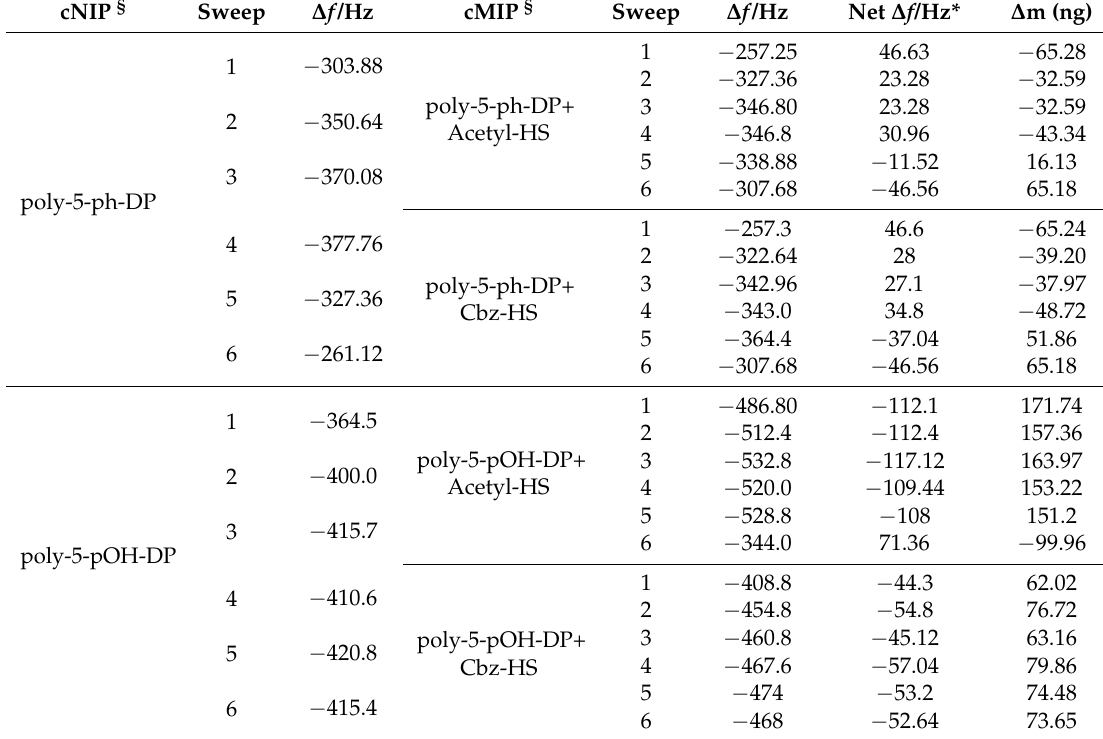
Table 4. Example of ∆ f (Hz) measured at each voltage sweep during cNIP and cMIP preparation. cNIP § Sweep ∆ f